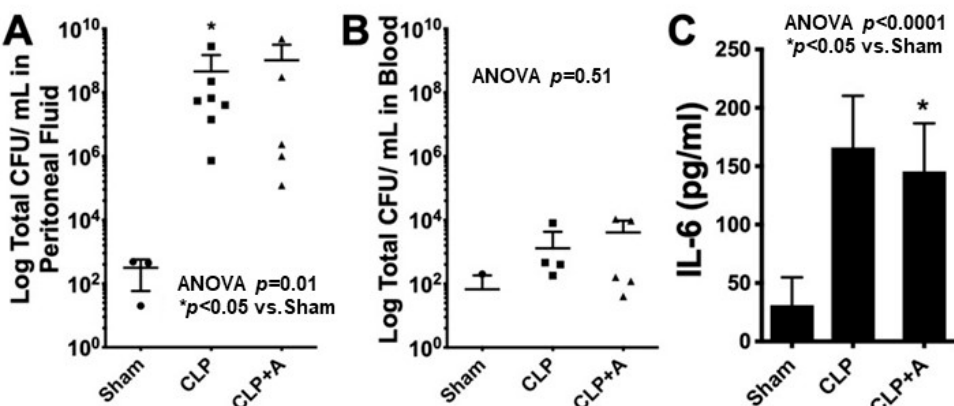
Figure 3. C57/BL6 mice were exposed to either sham surgery (Sham) or cecal ligation and puncture (CLP), and were treated with the AMPK activator 5-aminoimidazole-4-carboxamide-1- β -D-ribofuranoside (AICAR), (CLP+A) or vehicle (CLP). At 24 h, the animals were sacrificed and samples were obtained to assess outcomes. For more details on the experimental design please see the Supplementary Material. There was no difference in the bacterial colony forming units (CFU) between mice treated with AICAR or vehicle in the peritoneal fluid ( A ) or in blood ( B ). In addition, there were no differences in plasma levels of interleukin-6 (IL-6) ( C ). These results suggest that protection through AMPK activation is independent of resistance because there was no effect on bacterial burden, and therefore, must be operating through a Tolerance mechanism. * p value < 0.05 when compared to sham.